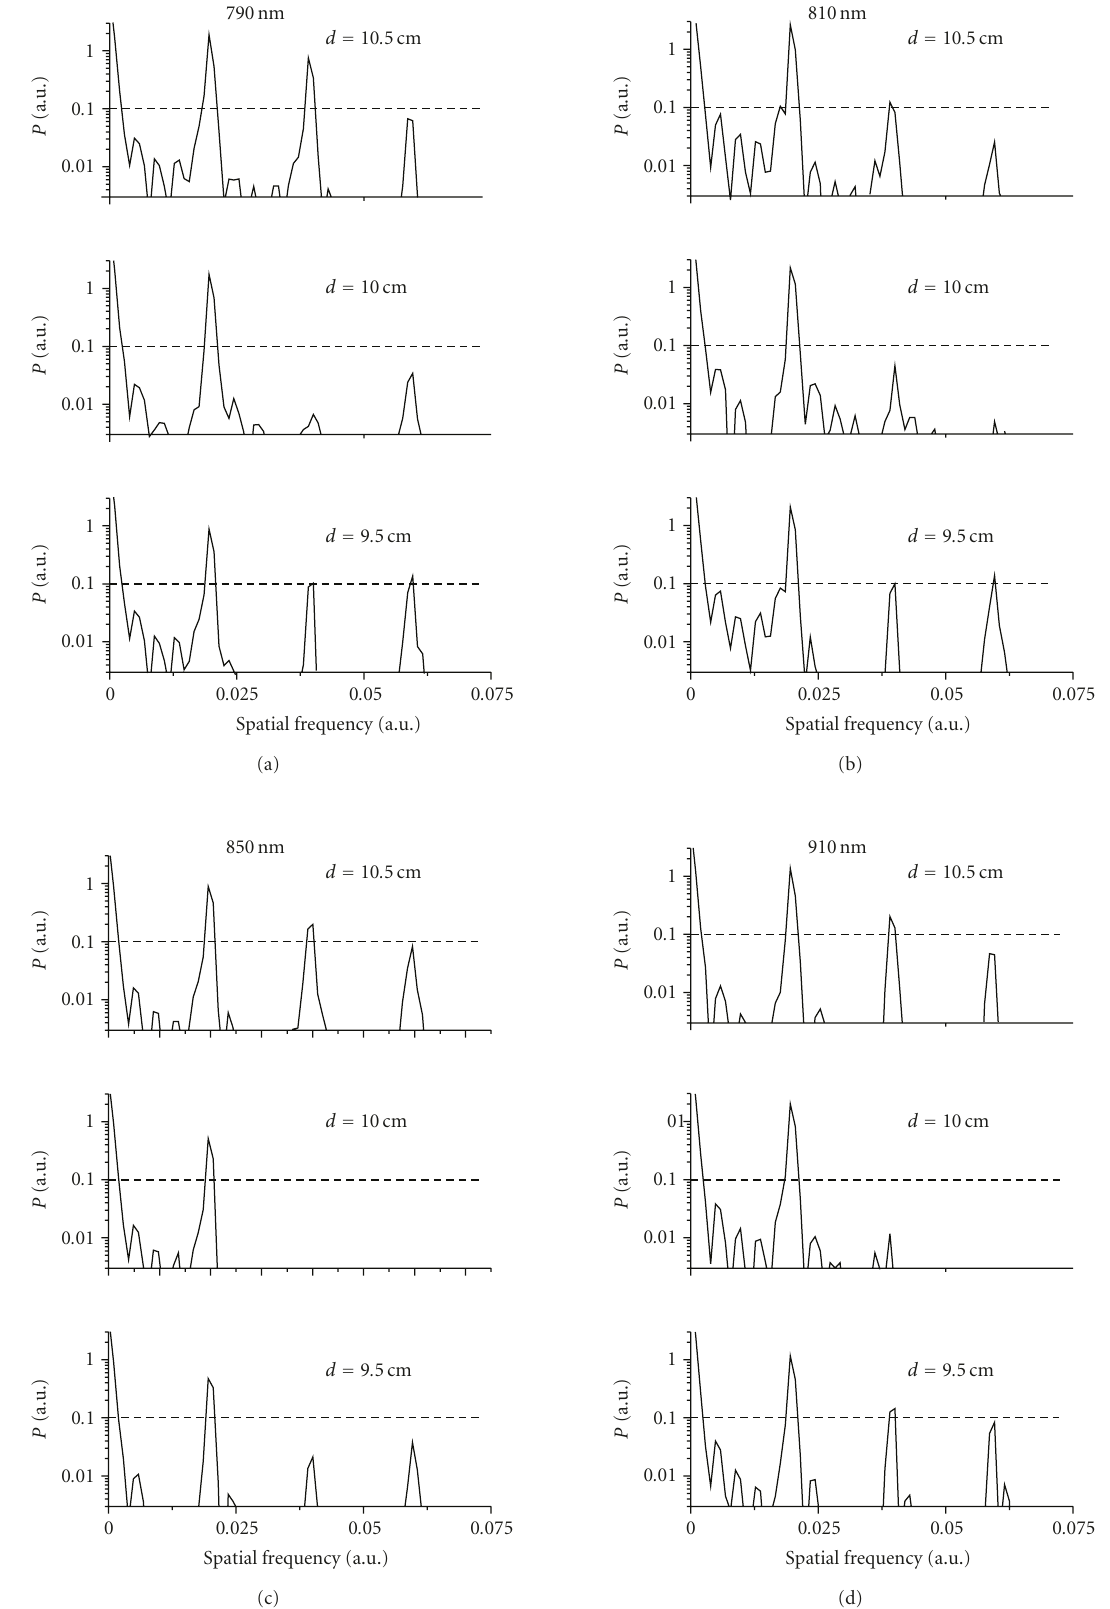
Figure 6: Frequency content of patterns created by a sinusoidal phase grating using an optical arrangement in Figure